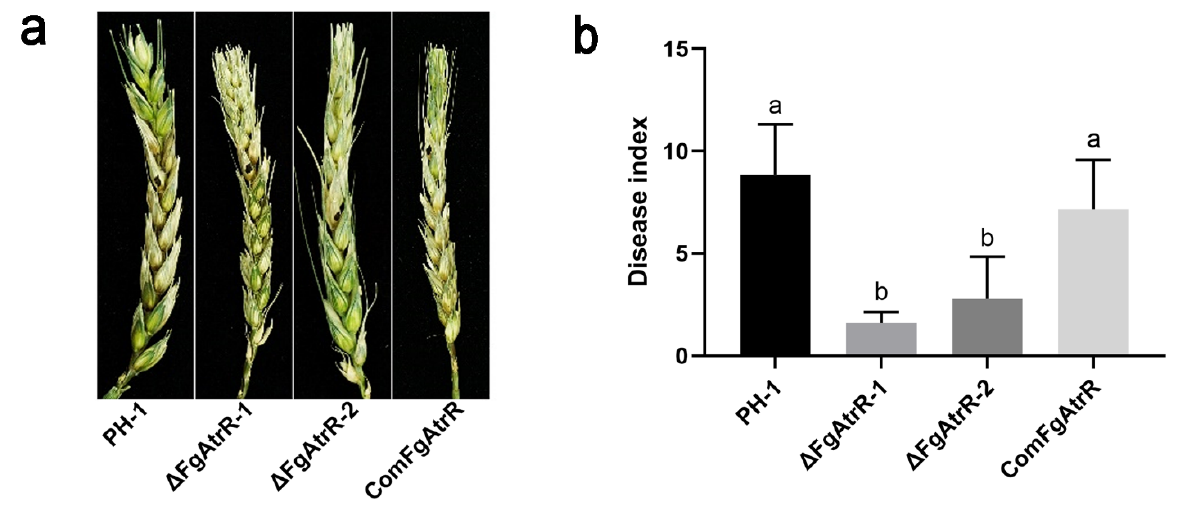
Figure 3. FgAtrR is required for full virulence of Fusarium graminearum . ( a ) The representative infected wheat heads were examined at 14 dpi with a 2 mm diameter mycelial plug of each strain. ( b ) The disease index was determined by the number of symptomatic spikelets per wheat head at 14 dpi. Ten flowering wheat heads were inoculated for each strain. Error bars showed the standard deviation. The same letters indicate no statistically significant difference at the p < 0.05 level.